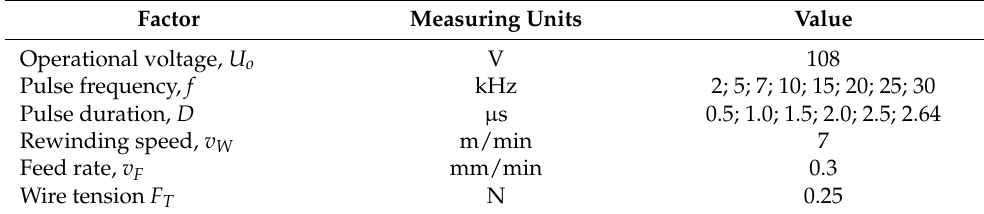
Table 6. Range of electrical discharge machining